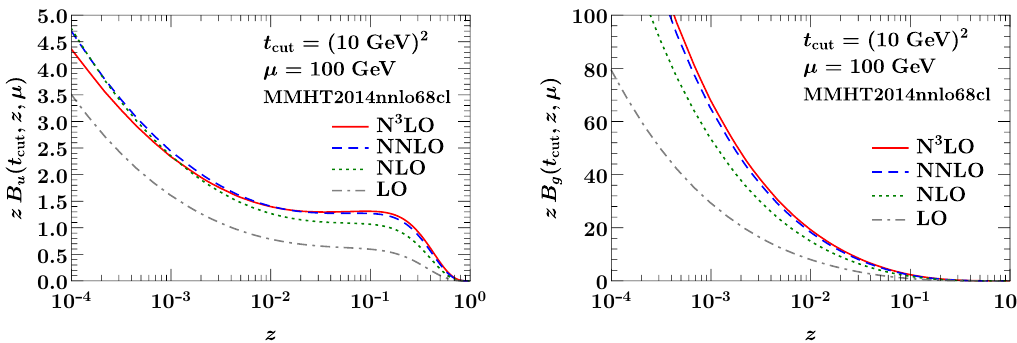
Figure 2 . The cumulative u -quark (left) and the gluon (right) beam functions as a function of z for (cid:12)xed t cut = (10 GeV) 2 and (cid:22) = 100 GeV. We show the result at LO (which corresponds to the PDF), NLO, NNLO and N 3 LO.